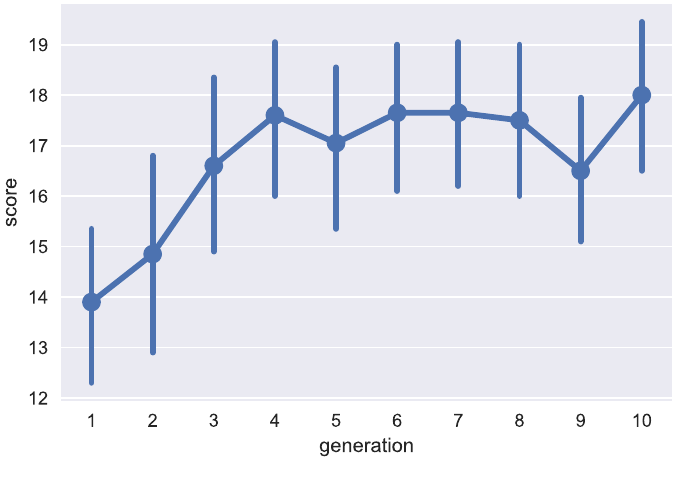
Figure 4 : The number of correct responses made by participants in testing (out of a maximum of 24) over generations. Boot- strapped 95% confidence intervals are shown. Accuracy increases over